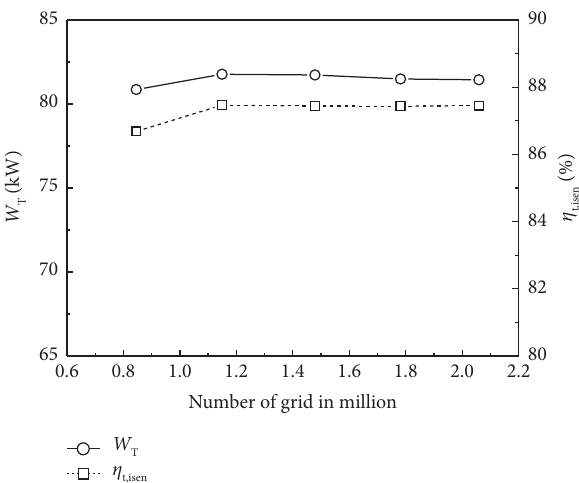
Figure 11: Te result of grid independence analysis.